Question: Is the quantity shown trending increasing or decreasing?
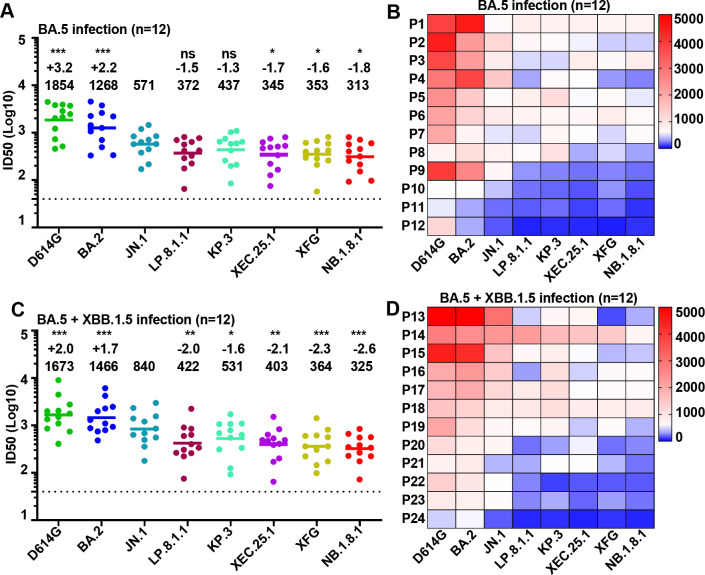
Answer: increasing